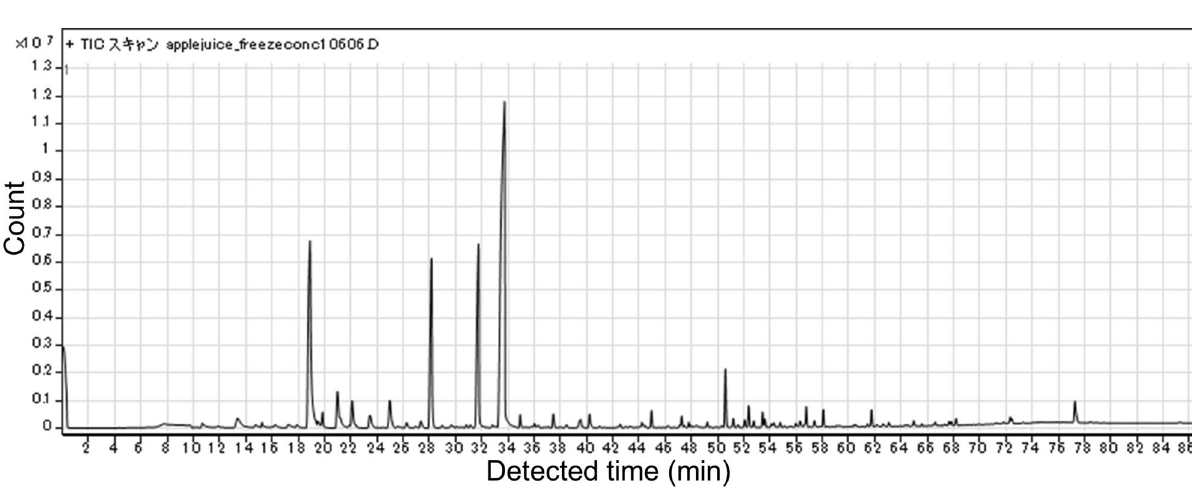
Figure 7. C hromatogram of apple juice concentrated by